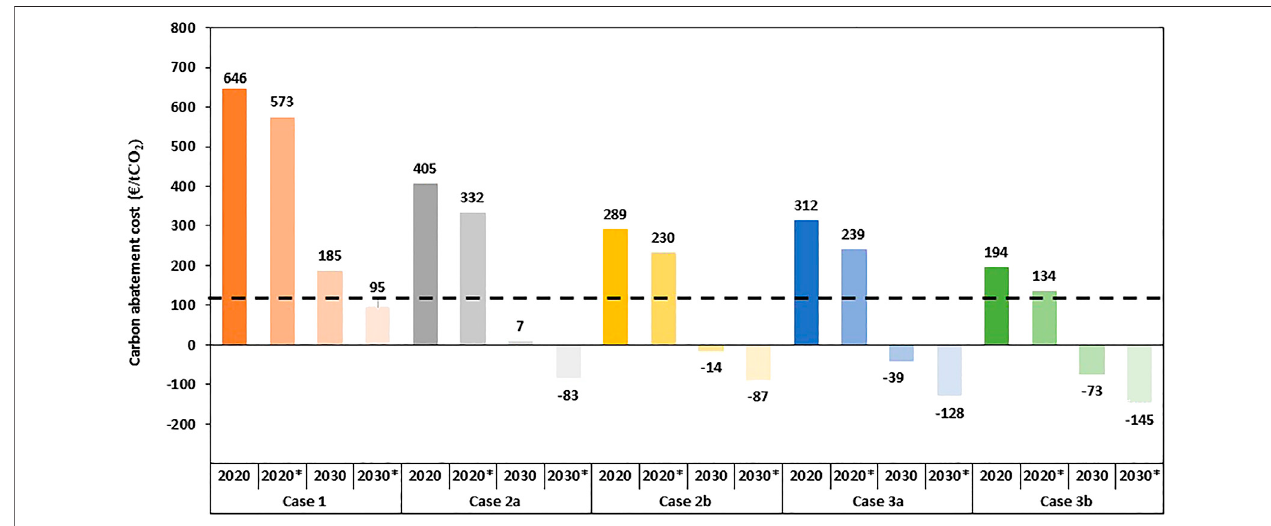
FIGURE 9 | Carbon abatement cost ofthe different cases assessed. Note: * means without diesel tax relief; black dotted line represents the carbon tax in Sweden (2020).